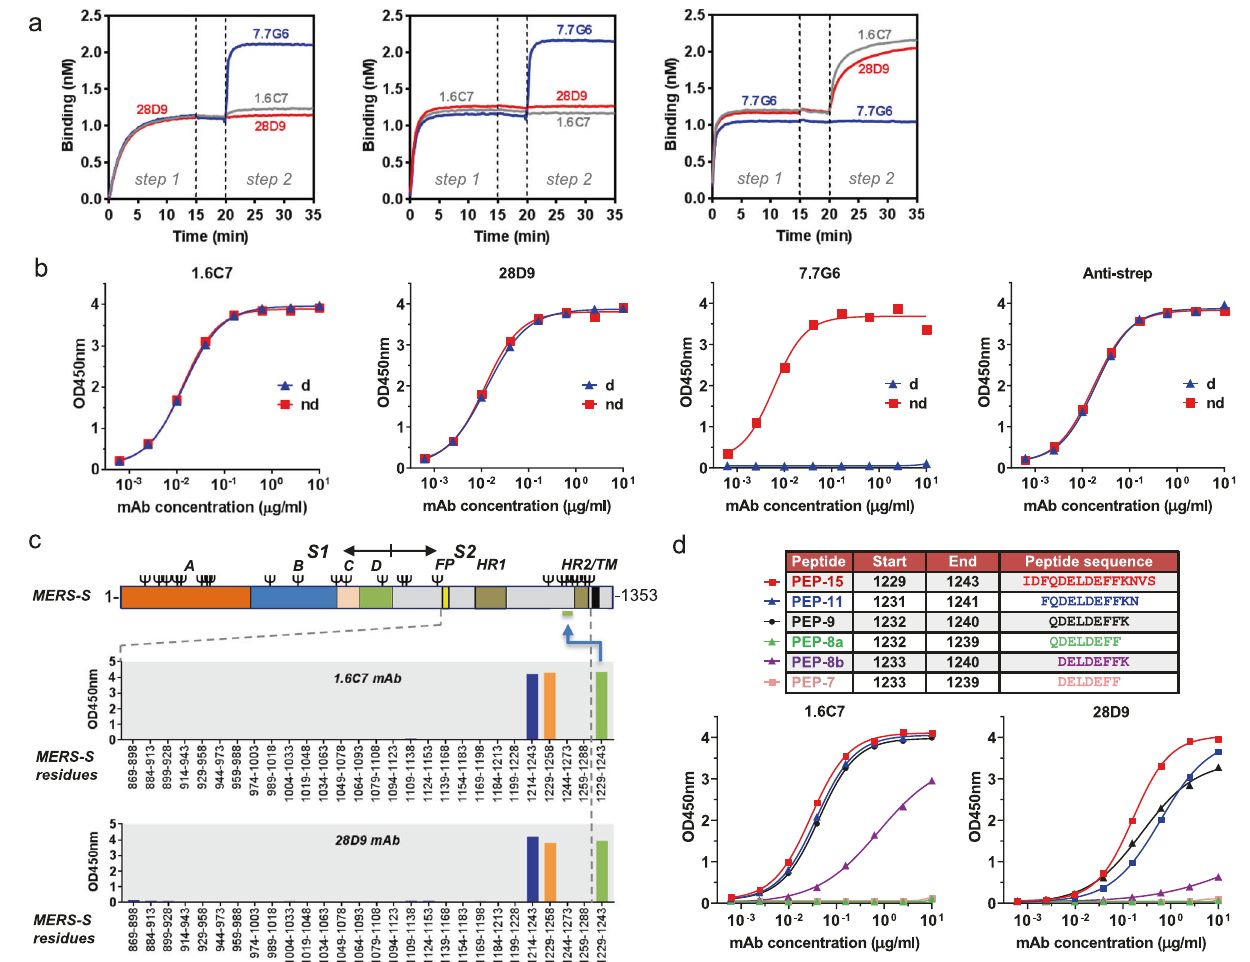
Fig. 3 mAbs 1.6C7 and 28D9 target a linear epitope located in the stem region of S2 fusion subunit. a Antibody binding competition analysed by biolayer interferometry. Immobilized MERS-S ecto antigen was saturated in binding with a given mAb (step 1) and then exposed to binding by a second mAb (step 2). Additional binding of the second antibody indicates the presence of an unoccupied epitope, whereas lack of binding indicates epitope blocking by mAb1. As a control, the fi rst mAb was also included in the second step to check for self-competition. The competitive binding was tested for the S2-targeting 1.6C7 and 28D9 antibodies and a MERS-S1 antibody control (7.7G6) 43 . Source data are provided as a Source Data fi le. b 1.6C7 and 28D9 recognize a linear epitope. ELISA binding curves of 1.6C7 and 28D9 to untreated MERS-S ecto (non-denatured: ‘ nd ’ ) versus MERS-S ecto that was heat-denatured in the presence of SDS and DTT (denatured: ‘ d ’ ). Two antibodies targeting the MERS-S1 domain (7.7G6) and the 8-residue long linear Strep-tag epitope (anti- strep) were used as controls. Source data are provided as a Source Data fi le. c 1.6C7/28D9 epitope maps to a 15-aa long stem region upstream of HR2 in MERS-S. ELISA-reactivity of 1.6C7 and 28D9 to a peptide library of 30-amino acid long peptides (with 15-a.a. overlap) covering the conserved C-terminal part of the MERS-S ecto (residues 869-1,288). Both antibodies reacted with two peptides (blue and orange bars), and with a peptide corresponding to their 15-a.a. long overlap (green bar; MERS-S residues 1,229 – 1,243). The position of the epitope containing region is indicated in the MERS-S protein schematic with the spike subunits (S1 and S2), S1 domains (A through D), fusion peptide (FP), heptad repeat 1 (HR1), heptad repeat 2 (HR2) and transmembrane domain (TM) annotated. Source data are provided as a Source Data fi le. d The 1.6C7/28D9 epitope maps to a 8-aa long peptide ‘ DELDEFFK ’ detected by ELISA. ELISA binding curves of 1.6C7 and 28D9 to N- and C-terminally truncated versions of the 15-mer peptide fragment of MERS-S. Data points represent the average from n = 2 technical replicates. Source data are provided as a Source Data fi